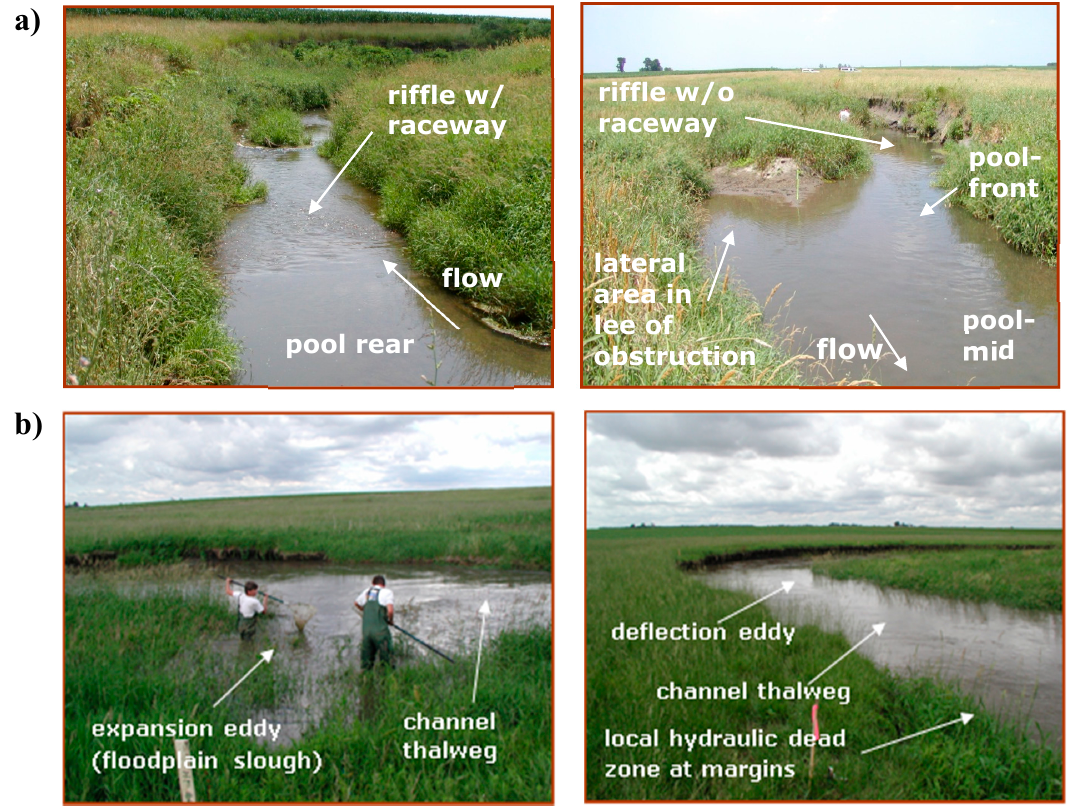
Figure 4. Photo showing examples of mesohabitat units during ( a ) low-flow and ( b ) high-flow stages in the Embarras River headwaters (third-order stream with 476 km 2 drainage basin); located approximately 15 km south of Urbana, IL, USA.